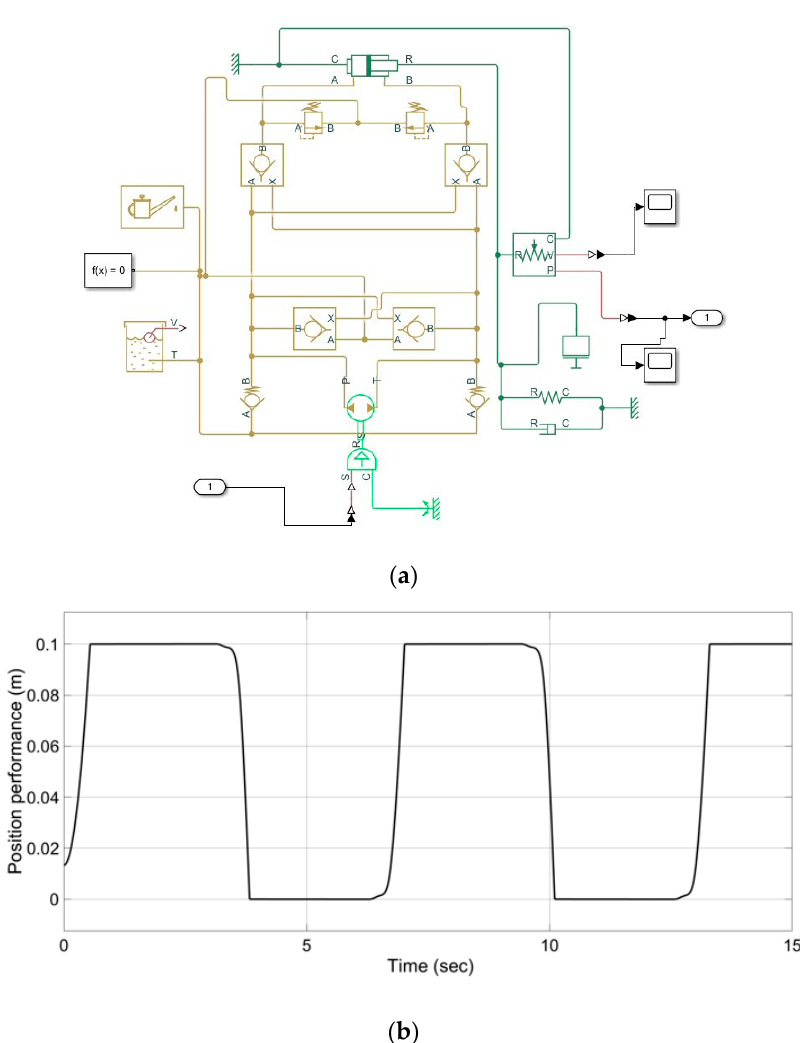
Figure 3. Result of the sine wave in the pump-controlled electro-hydraulic actuator (EHA) without a controller: ( a ) is designed with a hydraulic circuit, and ( b ) is the result of the position performance via Simscape Fluid. Table 1. Hydraulic Parameters for the electro-hydraulic actuator (EHA) Simulation.